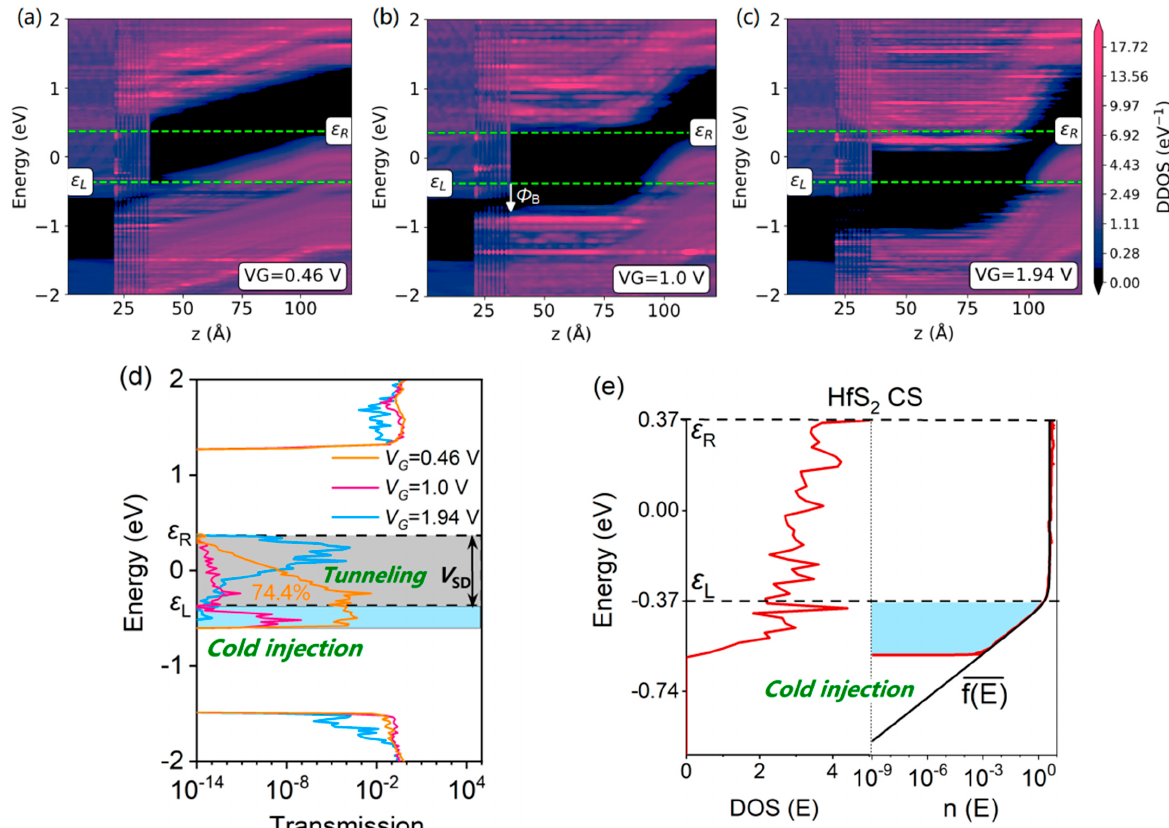
Figure 4. Device density of states (DDOS) projected to source, channel, and drain regions of the HfS 2 /MoTe 2 CS-FET. DDOSs at ( a ) the on-state of the p-type transport ( V G = 0.46 V), ( b ) the steepest SS state of the p-type transport ( V G = 1.0 V), and ( c ) the on-state of the n-type transport ( V G = 1.94 V). Zero energy is set to be the average Fermi level of the source ( ε L ) and drain ( ε R ). ( d ) Comparison of the transmission spectrum at different states. ( e ) Density-of-states-energy relation D ( E ) and carrier density n ( E ) of the n-doped HfS 2 source. n ( E ) shows the desired truncated decreasing (or the super- exponentially decreasing) trend. For comparison, the exponentially decreasing Boltzmann distribu- tion function )( Ef that equals n ( E ) at the source Fermi level ε L is shown by the black curve. 4. Conclusions Our simulation demonstrates the feasibility of using the 2D semiconductor HfS 2 as an efficient CS to produce a steep-slope p- and n-type MoTe 2 transistor. The truncated decreasing n(E) relation, the weak vdW interaction, and the tunneling effect are critical to the performance of MoTe 2 FET. Specifically, the band gap of the HfS 2 source could effec- tively suppress the carrier injection into the MoTe 2 channel, resulting in a low SS of 33 mV/decade in the p-type HfS 2 /MoTe 2 FET. The direct source-to-drain tunneling effect can increase the on-state current by more than two orders of magnitude. On the other hand, we found that in n-type HfS 2 /MoTe 2 FET, the inter-band tunneling behavior at the chan- nel-drain interface can reduce SS to 41 mV/decade. Therefore, such a hybrid transport mechanism in HfS 2 /MoTe 2 FET can be used as an efficient strategy to optimize the on-state current and SS of the next-generation 2D FETs. Author Contributions: Conceptualization, J.L. and J.G.; software, J.G.; validation, J.G. and J.L.; formal analysis, J.G. and J.L.; investigation, J.L.; resources, J.L.; data curation, J.L.; writing-original draft preparation, J.L.; writing-review and editing, J.G.; All authors have read and agreed to the published version of the manuscript. Funding: This research was funded by the National Natural Science Foundation of China, grant number 11964022. Data Availability Statement: The data that support the findings of this study are available from the corresponding author upon reasonable request. Conflicts of Interest: The authors declare no conflicts of interest.